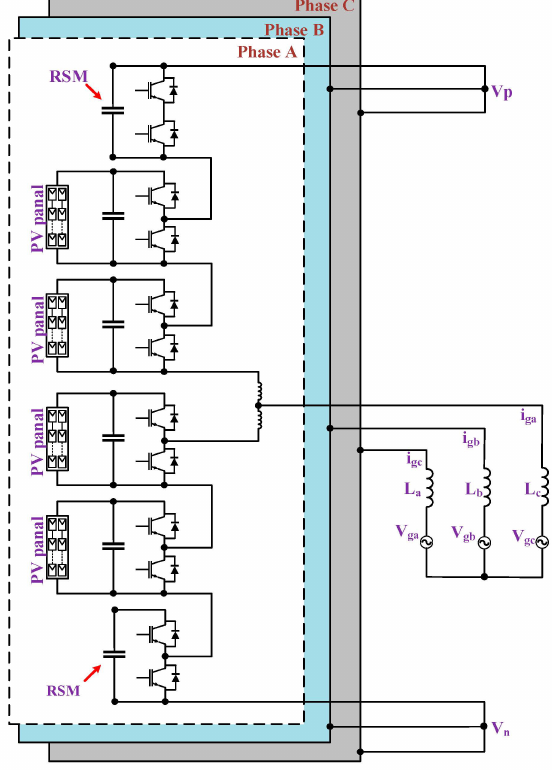
Figure 14. An MMC with a direct connection to a PV panel